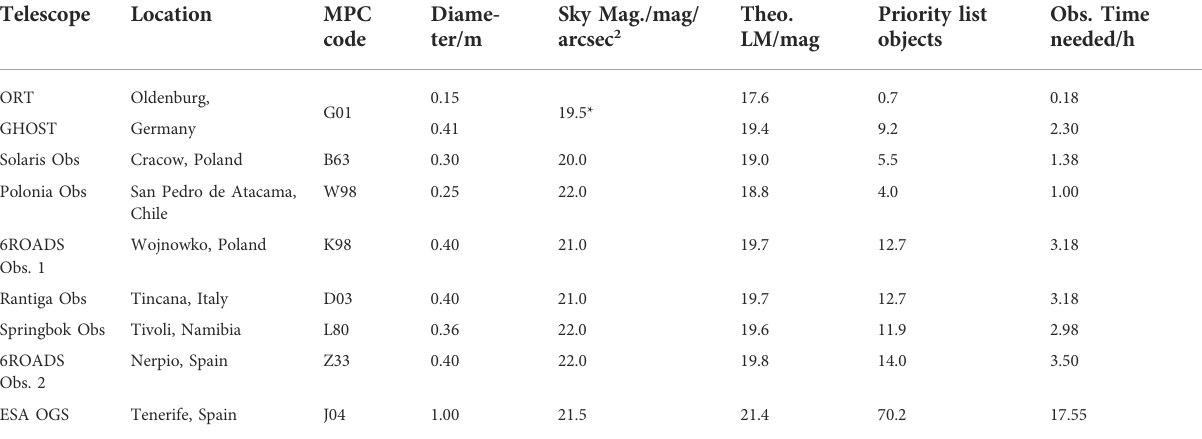
TABLE 2 Telescopes in Oldenburg (GHOST, ORT), from the 6ROADS Network and ESA ’ s Optical Ground Station (OGS) with their location, MPC Code and the results for the calculated Limiting Magnitude for the given diameter and Sky Magnitudes from Figure 6, the mean observable NEOCC Priority List object from Figure 8 and the mean observation time needed for those